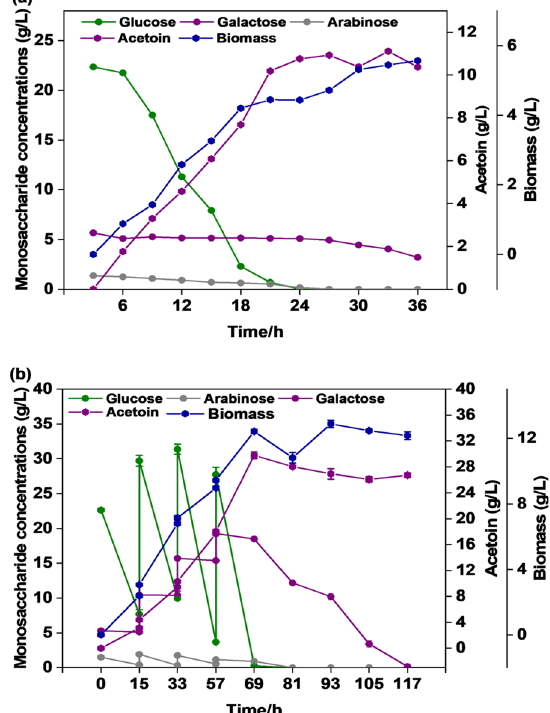
Fig. 7 Batch fermentation a and fed-batch fermentation of recombinant strains in okara enzymatic hydrolysate medium to produce acetoin ( b